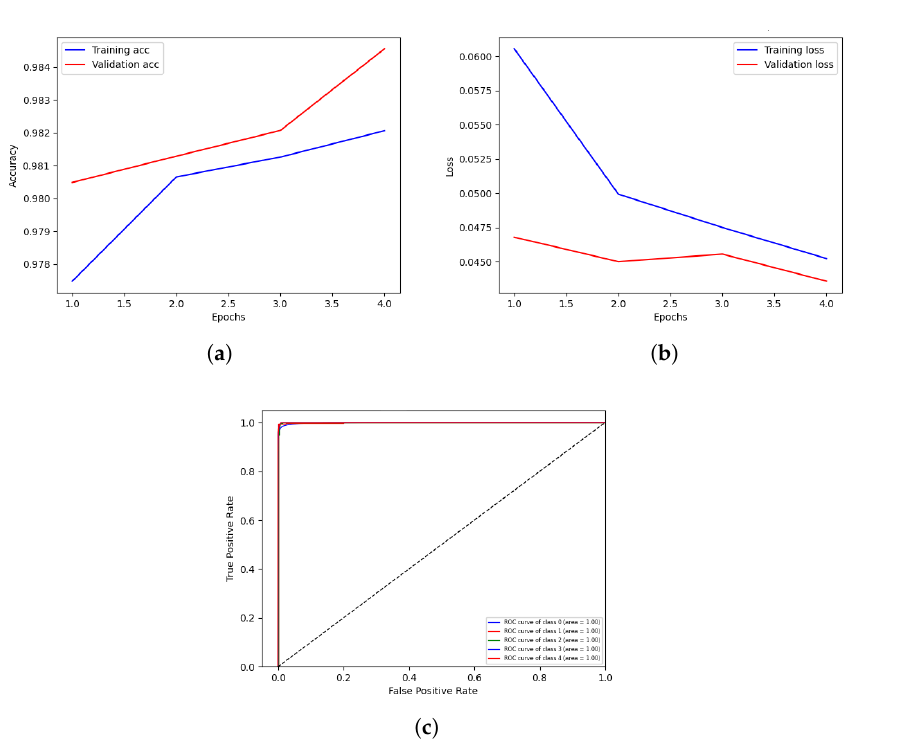
Figure 4. Visualization of client 2 highest-scoring results. ( a ) validation and training accuracy of round 3; ( b ) Validation and training loss of round 3; ( c ) Round 3 score of Receiver Operation Characteristic.